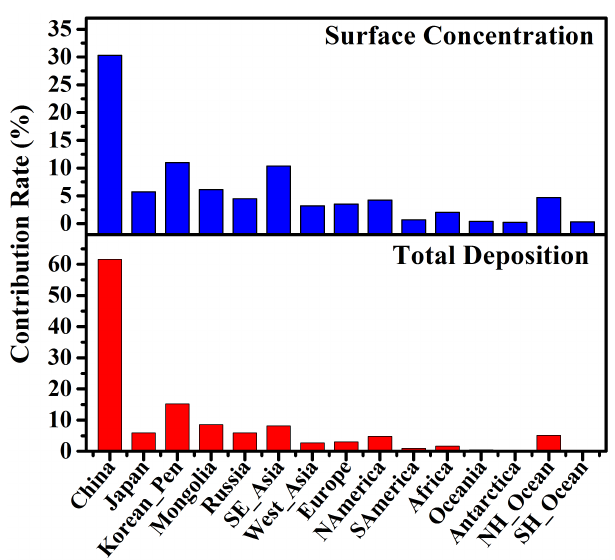
Figure 13. Mean percentage contributions (%) from Chinese pri- mary anthropogenic sources to annual mercury surface concentra- tions and total (wet plus dry) deposition over different world re-